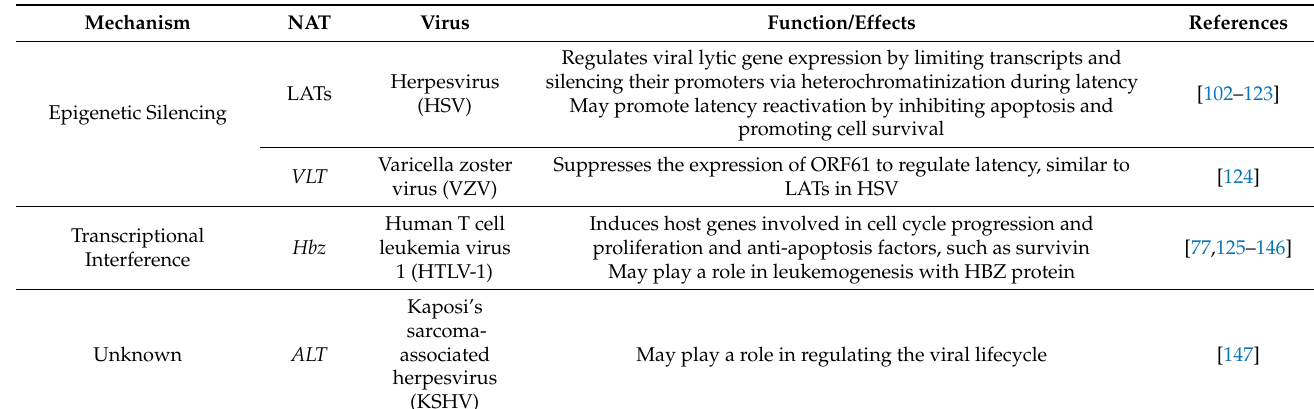
Table 2. NATs in viral